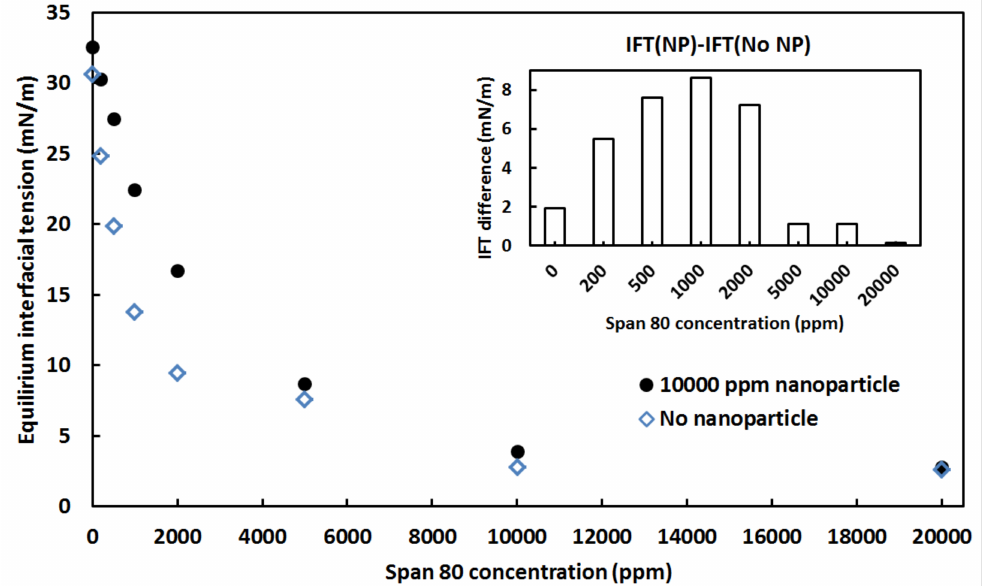
Figure 5. Equilibrium crude oil-water interfacial tensions in the presence of nanoparticles at different Span 80 concentrations and interfacial tension (IFT) difference between the systems with nanoparticles and without